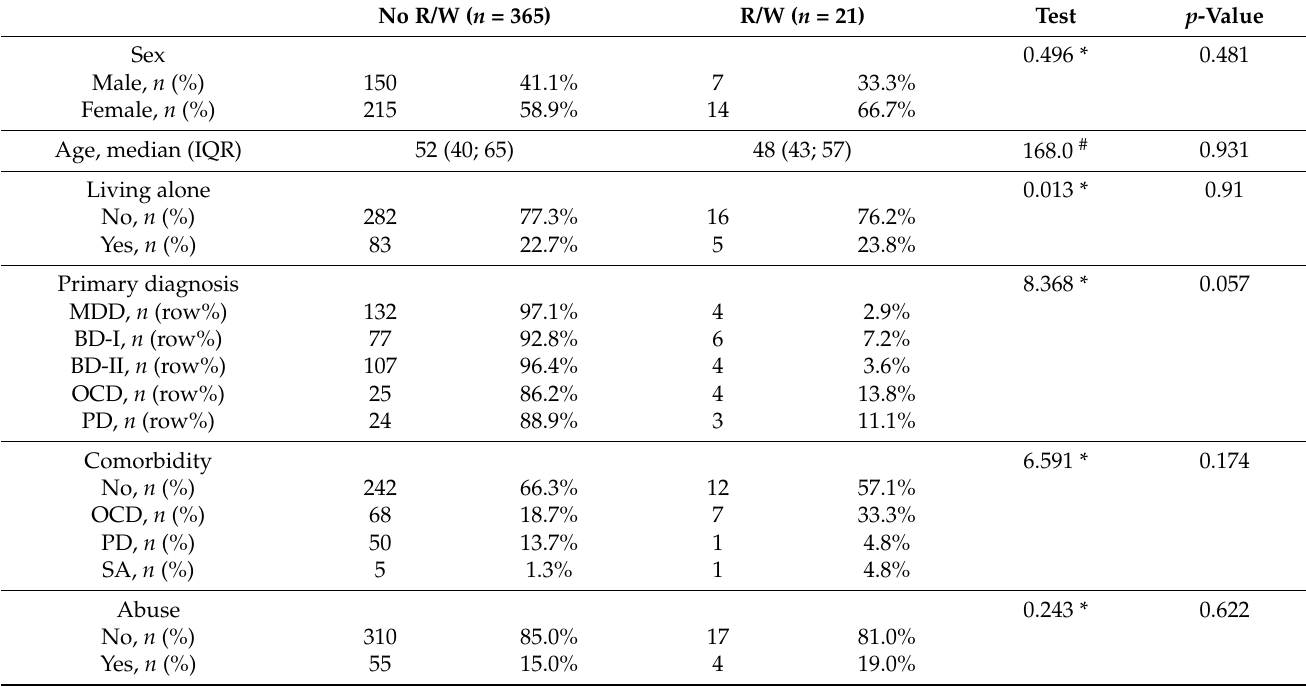
Table 1. Association of sociodemographic and clinical characteristics with the outcome relapse/worsening (R/W) vs. no relapse/worsening (No R/W) related to COVID-19